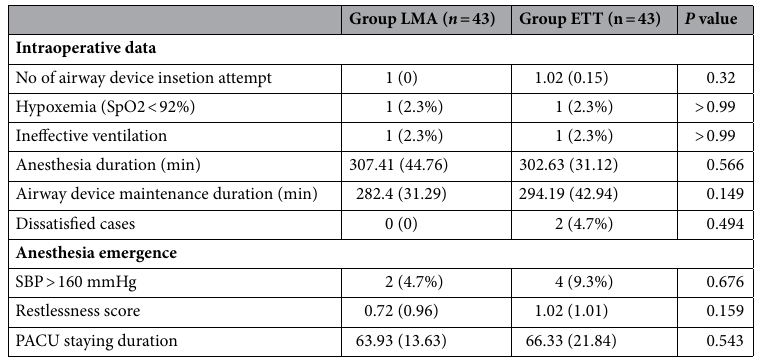
Table 2. Intraoperative and emergence variables. Data are expressed as mean (SD) or number (%). SBP systolic blood pressure.